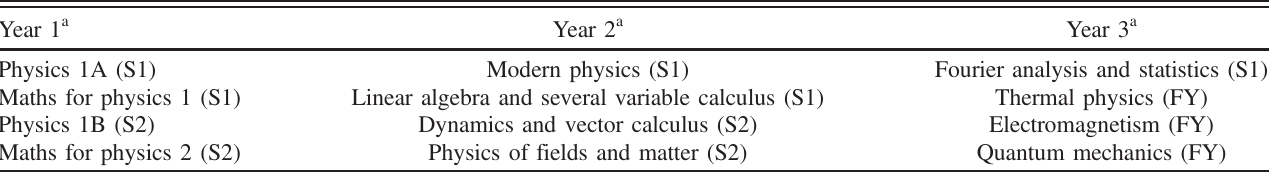
TABLE V. Compulsory courses: First year entry.